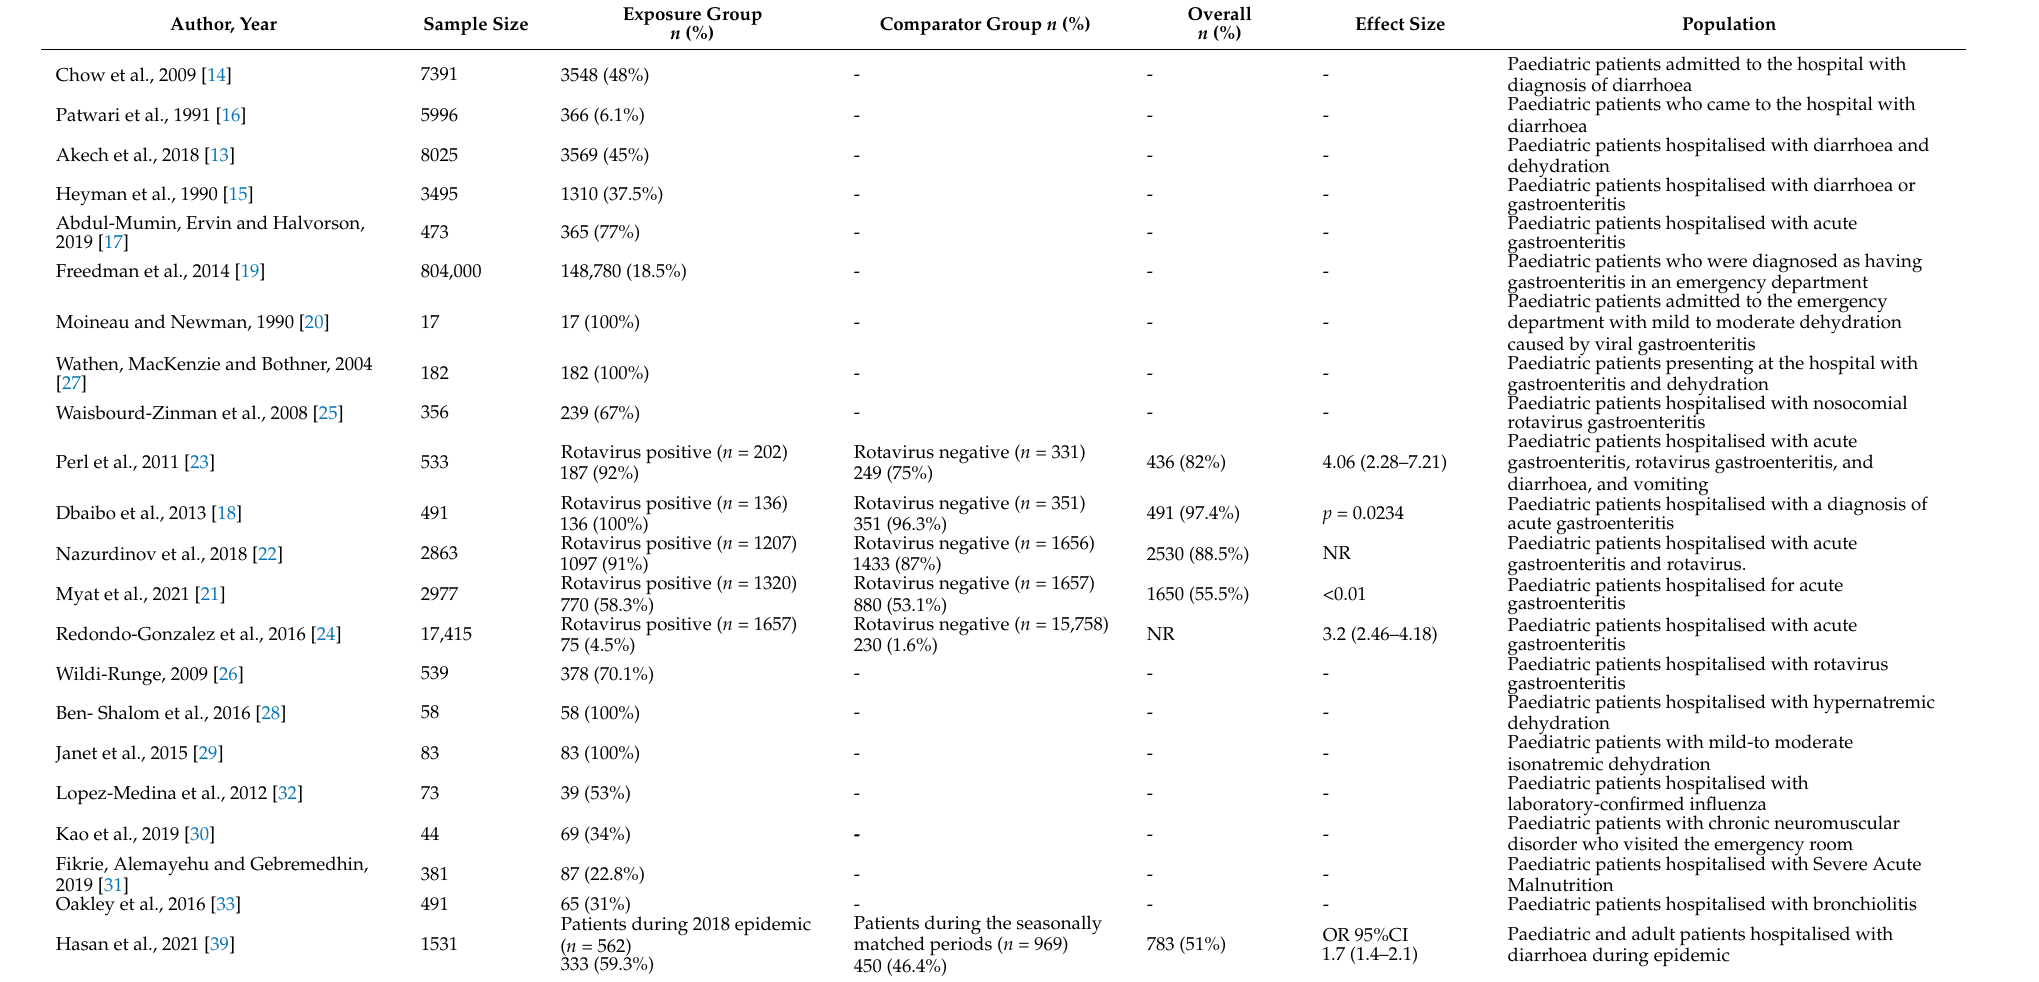
Table 2. Frequency of IV rehydration in paediatric and adult